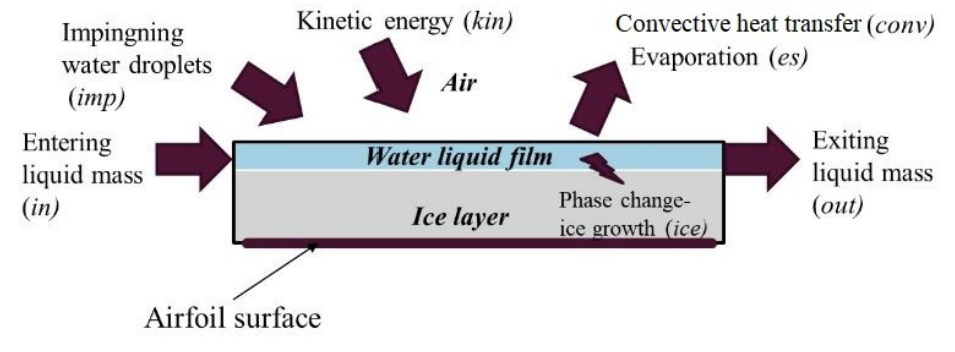
Figure 3. Control volume and energy and mass terms used in the Messinger icing model.